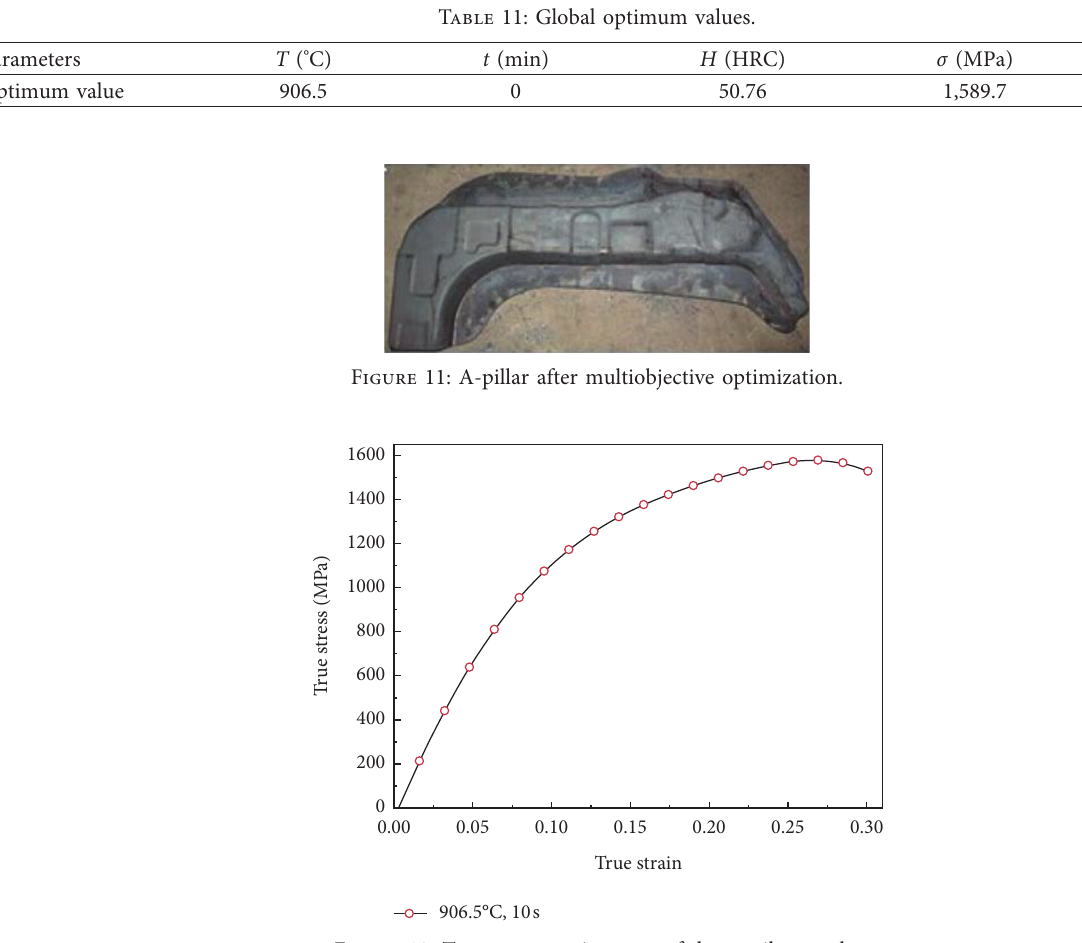
Figure 12: True stress-strain curve of the tensile